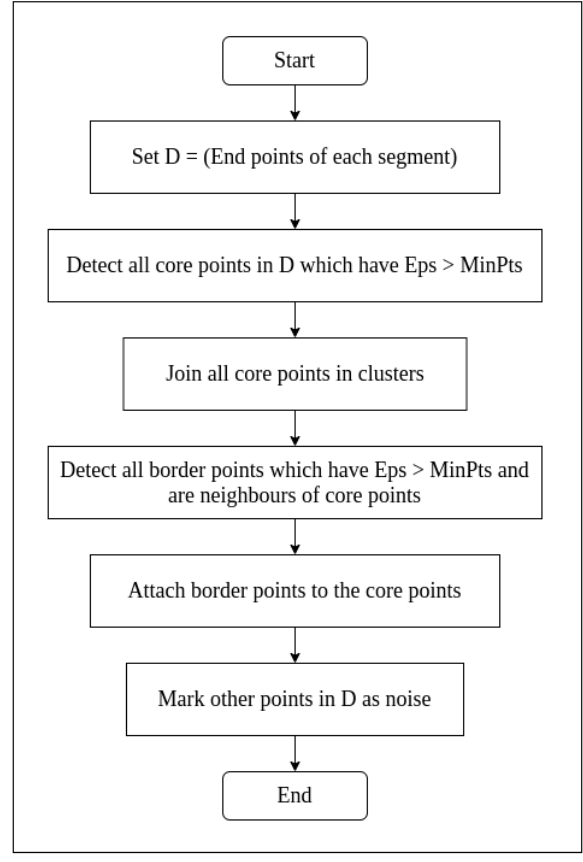
Figure 5. Flow chart of DBSCAN algorithm.